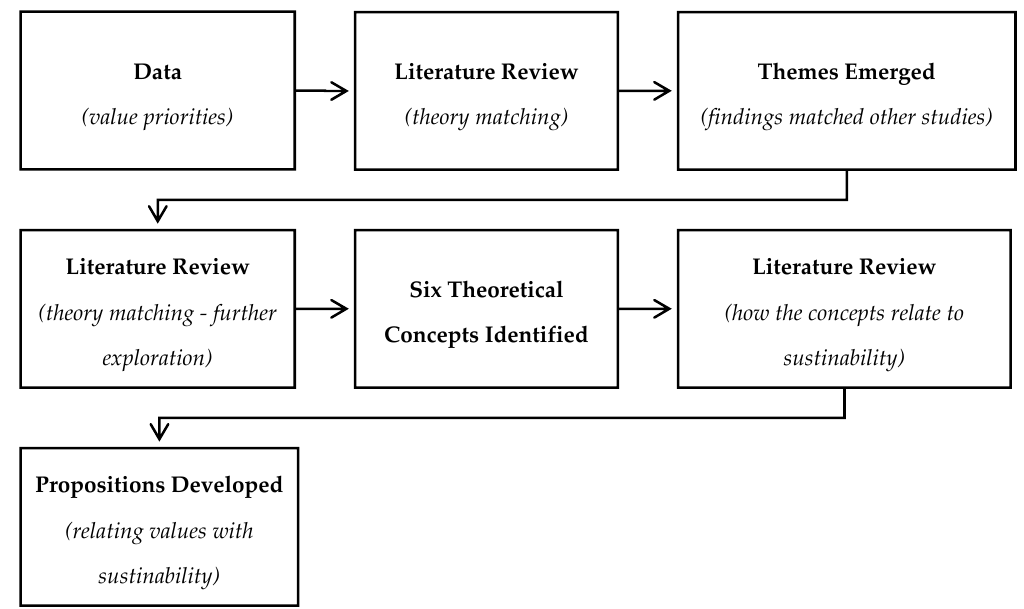
Figure 3. An overview of the process undertaken to develop the propositions.